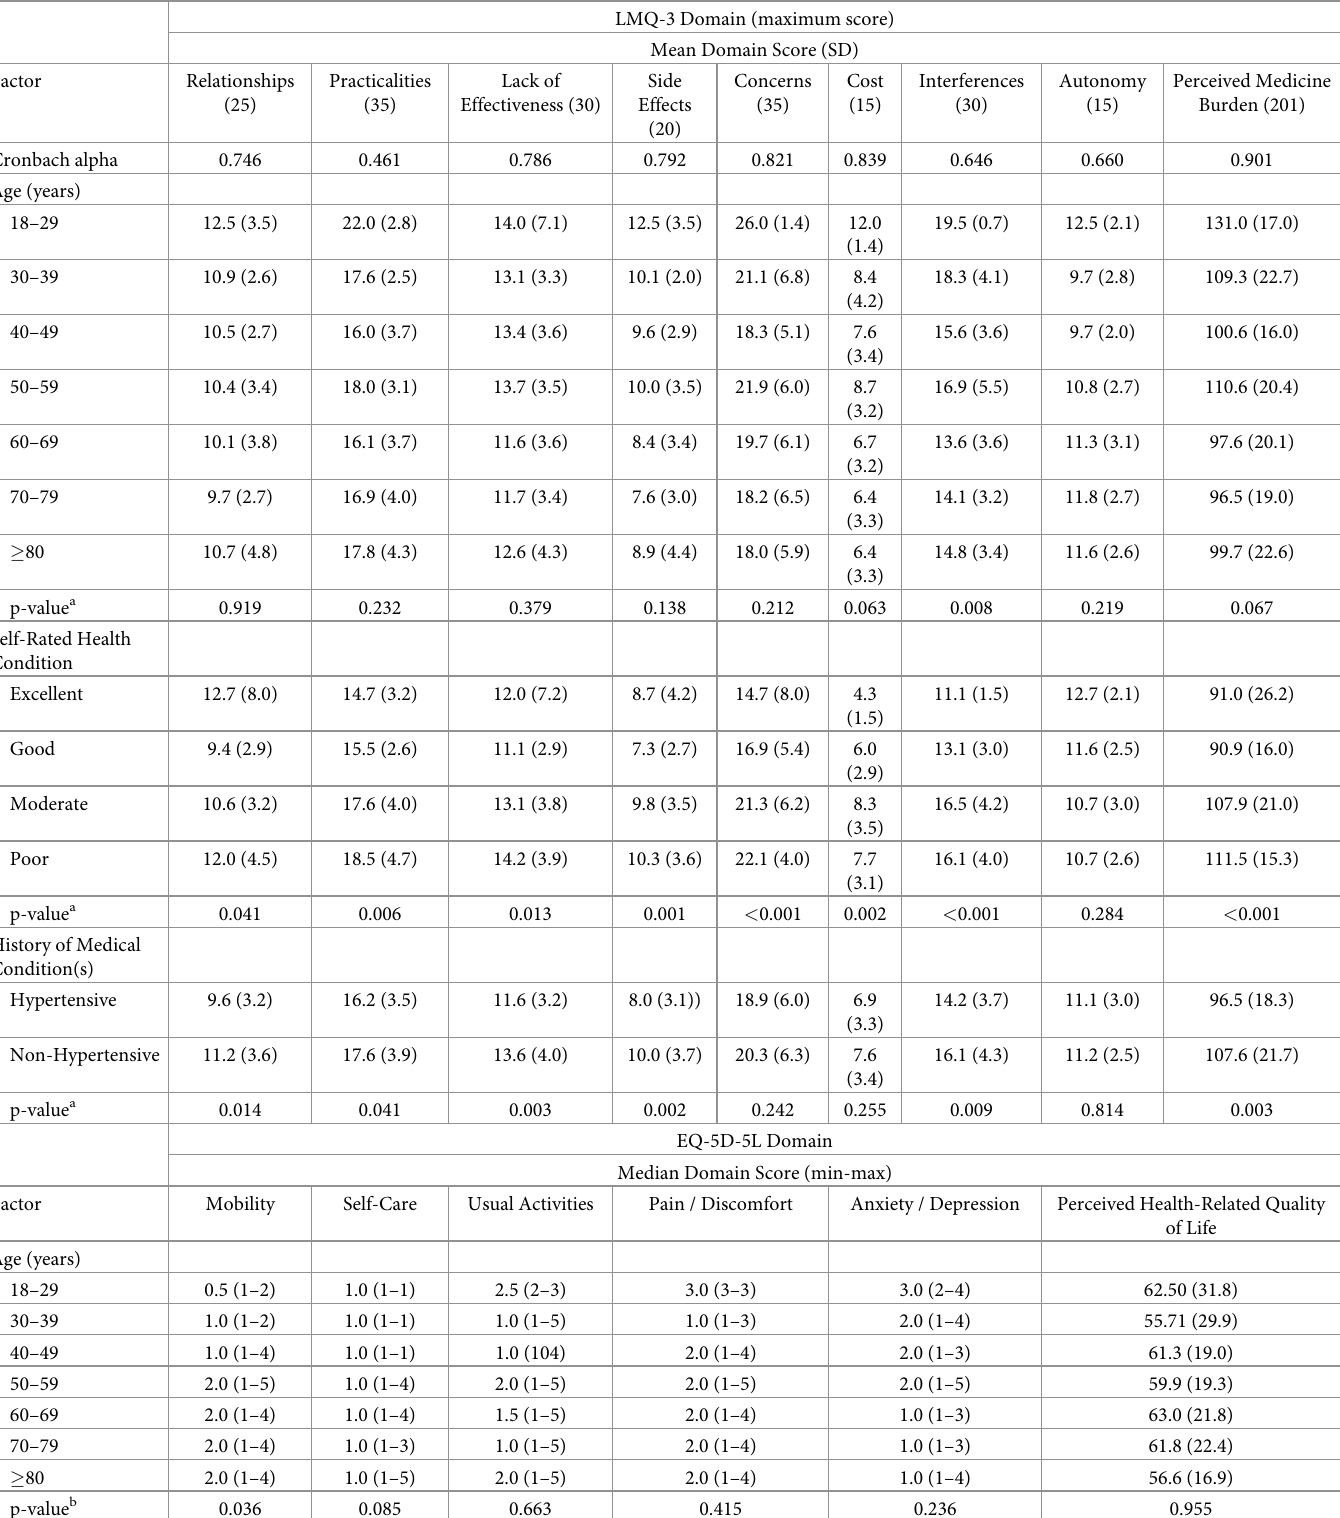
Table 3. LMQ-3 and EQ-5D-5L domain scores with significant demographic